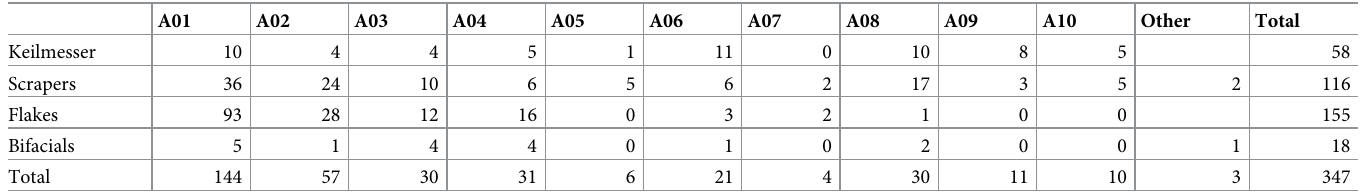
Table 1. Distribution of analyzed tools for techno-typological categories and inventory (from Richter